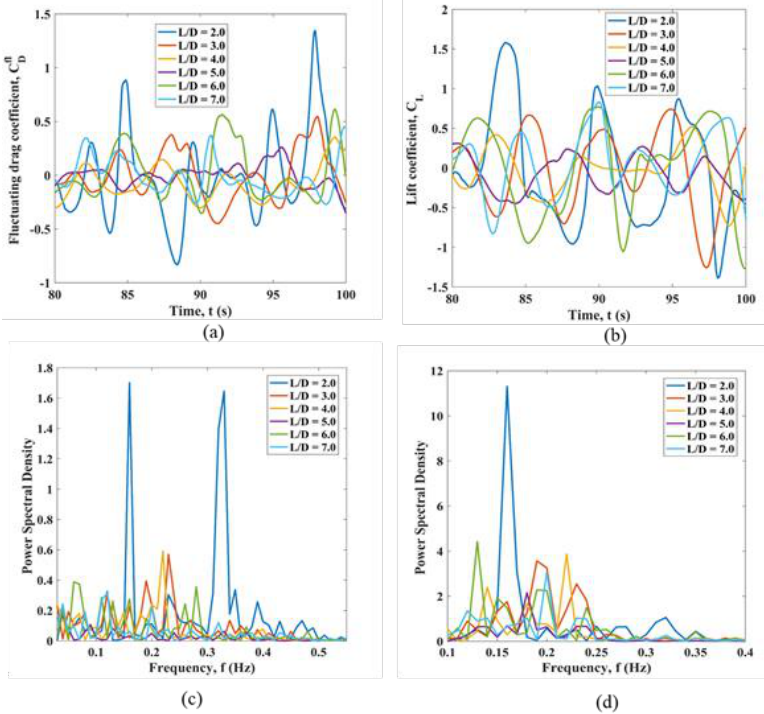
Figure A7. Fluid force coefficients for cylinder 3 immersed in planar sheared flow: ( a ) time history of the fluctuating drag coefficient; ( b ) time history of the lift coefficient; ( c ) the fluctuating drag co– efficient FFT; ( d ) the lift coefficient FFT.